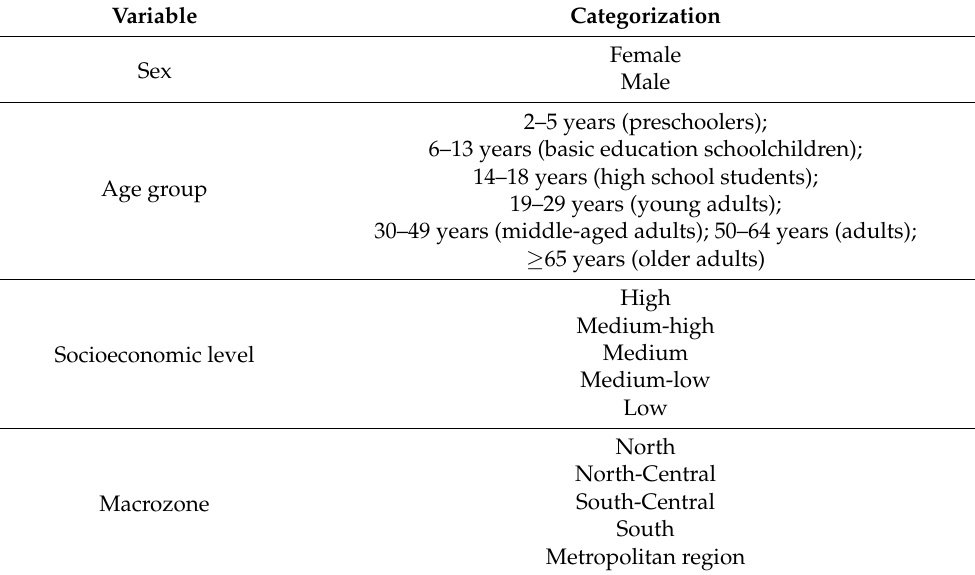
Table A1. Variables of the National Food Consumption Survey of Chile.